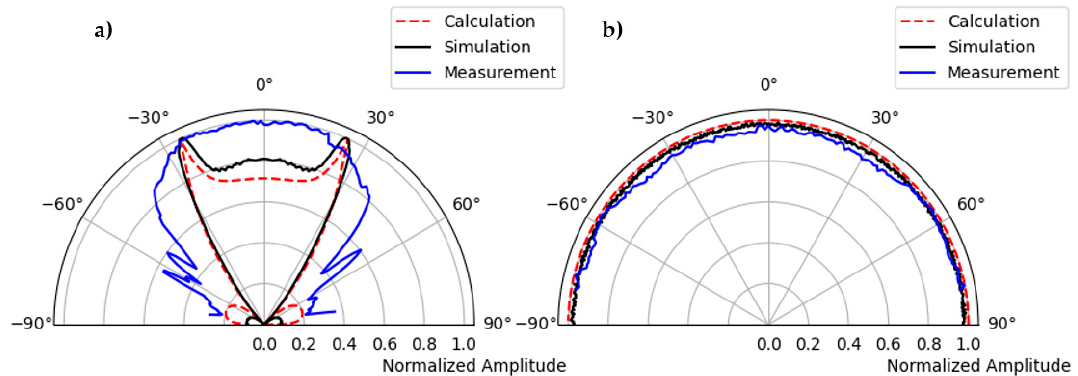
Figure 16. ( a ) Comparison of calculation, simulation, and measurement of radiation pattern of shear horizontal wave, polarization along the test plane, ( b ) polarization perpendicular to the test plane.